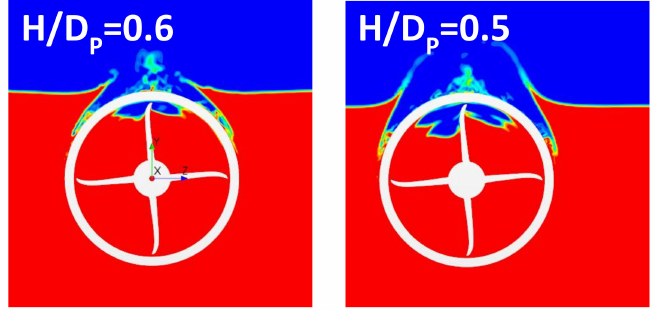
Figure 22. Contours of volume fraction under fully ventilated conditions at the submergence values of H/Dp = 0.6 and 0.5, J =